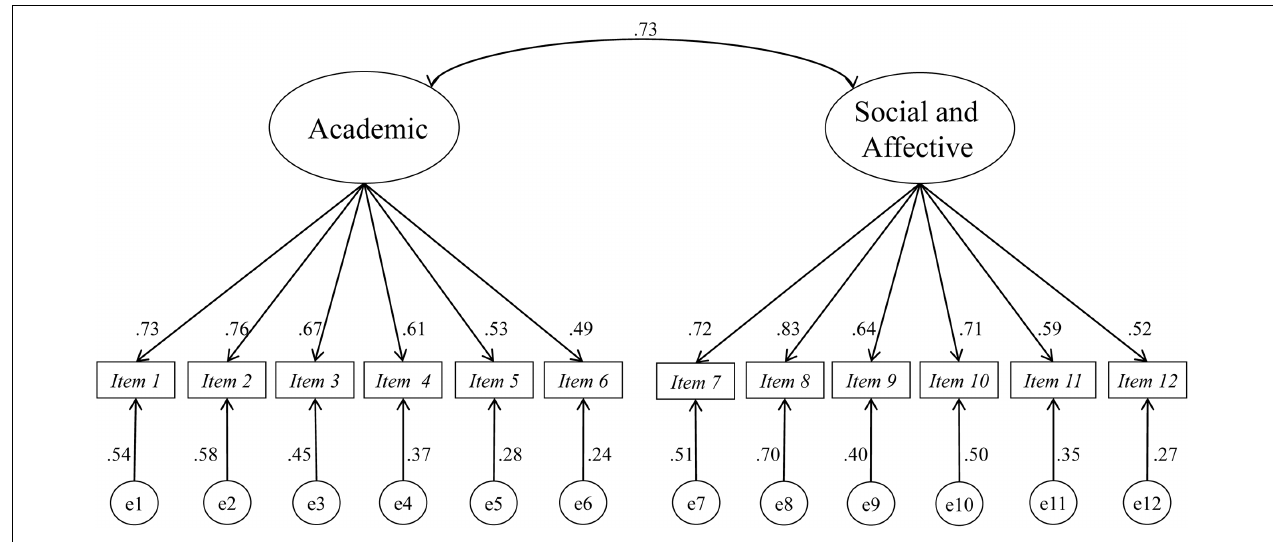
FIGURE 1 | Two-related factor model of the “Questionnaire of attiudes toward learning teams” (CACTE).